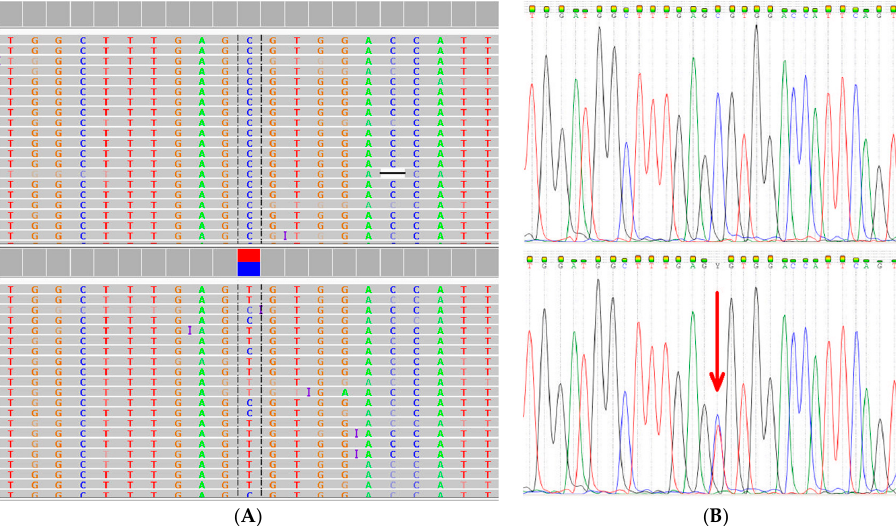
Figure 2. Detection of the RAD50 missense mutation R385C (rs139372231, Refseq mRNA accession NM_005732.3) using whole exome sequencing ( A ); and visualized using the Integrative Genome Viewer software tool [36]. The C to T base change at nucleotide position 1153 was confirmed by Sanger sequencing ( B ) as indicated by the arrow.